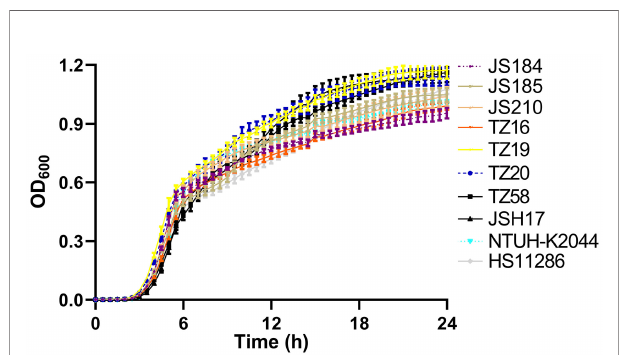
FIGURE 6 | Growth curves of 10 putative bla KPC (+)-HvKP and Hv- bla KPC (+)-KP strains. bla KPC , beta-lactamase K. pneumoniae carbapenemase gene; bla KPC (+)-HvKP, bla KPC (+) hypervirulent K. pneumoniae ; Hv- bla KPC (+)-KP, hypervirulent bla KPC (+) K. pneumoniae ; OD 600 , optical density at 600 nm.